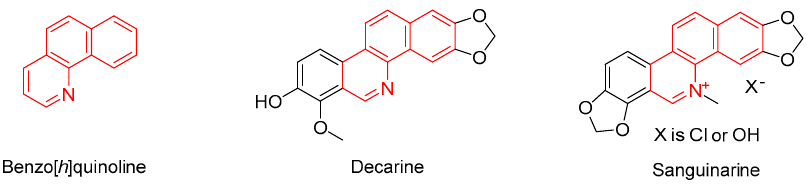
Figure 1. Structures of benzo[ h ]quinoline and two of its natural derivatives.